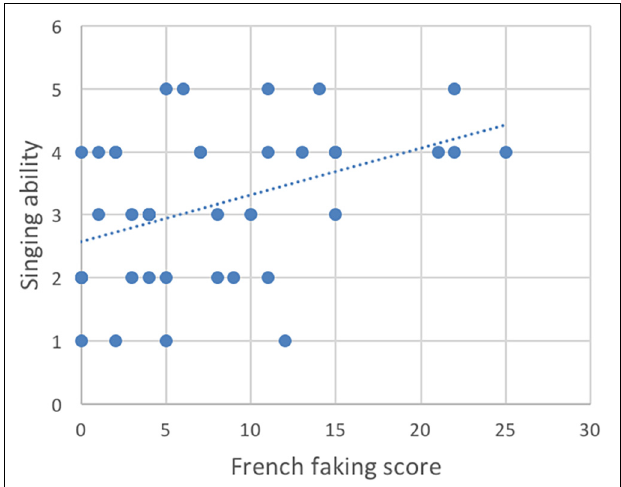
FIGURE 1 | Correlation of speakers’ musical abilities on the two parts of the Advanced Measures of Music Audiation (AMMA) test with the French faking scores.